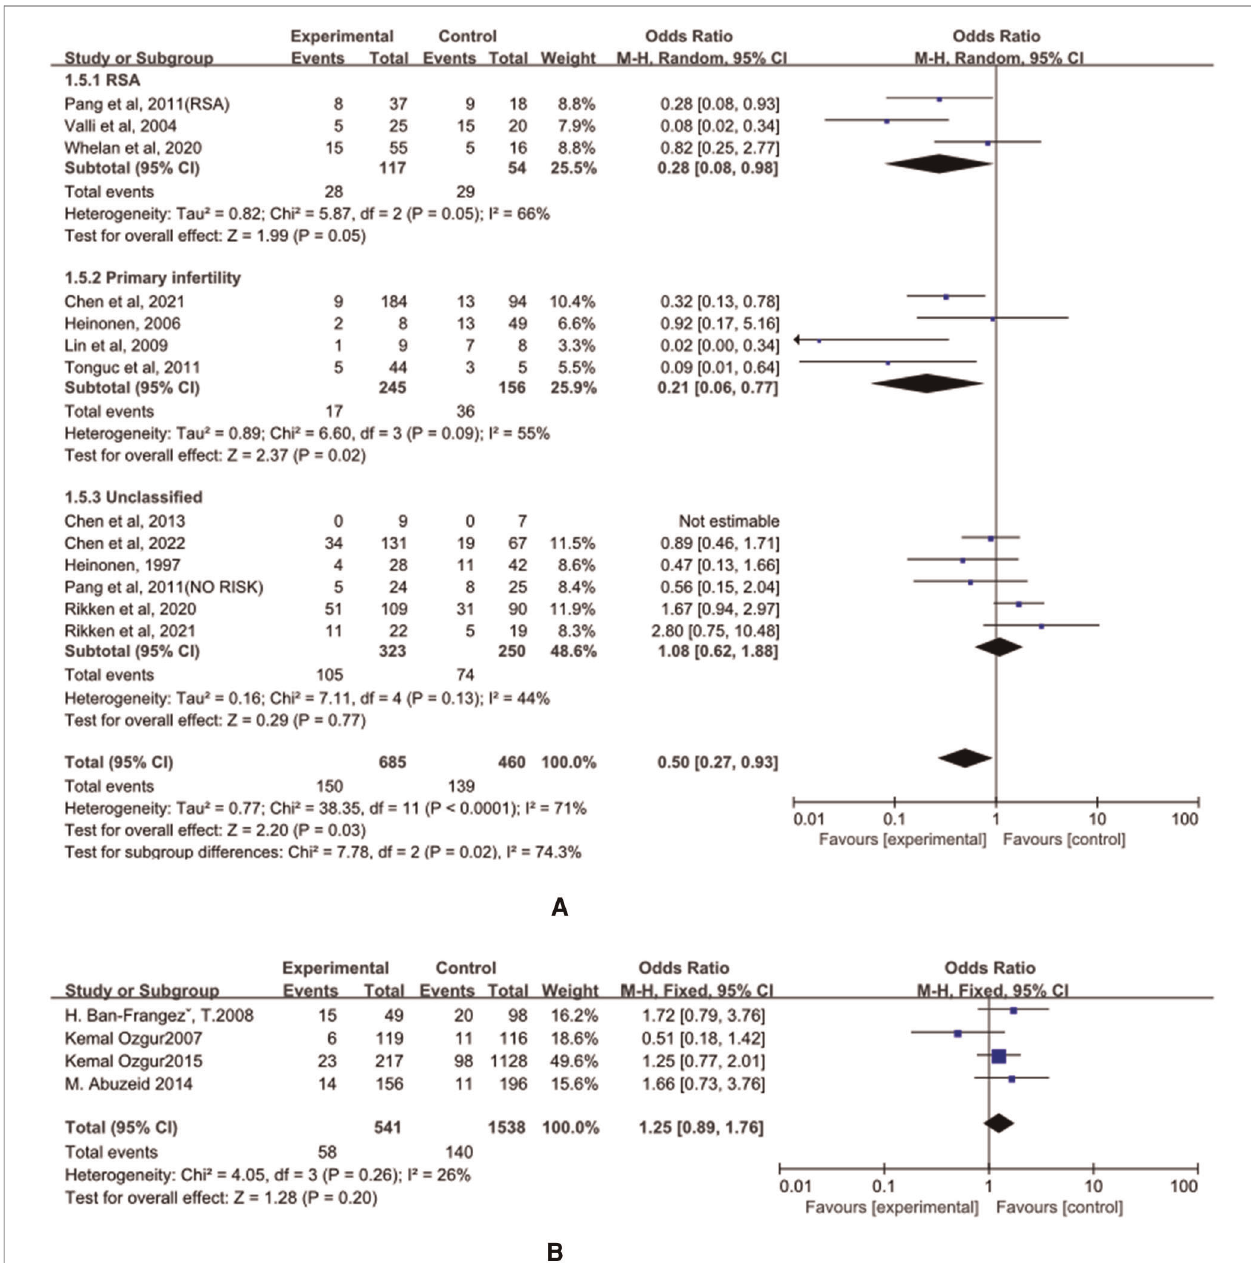
FIGURE 6 | The effect of hysteroscopic metroplasty on spontaneous miscarriage. ( A ) The control group of untreated women with septum uterus, and the study group was patients who underwent hysteroscopic surgery. ( B ) The control group of these articles was women with intact uterus, and the study group was patients who underwent hysteroscopic